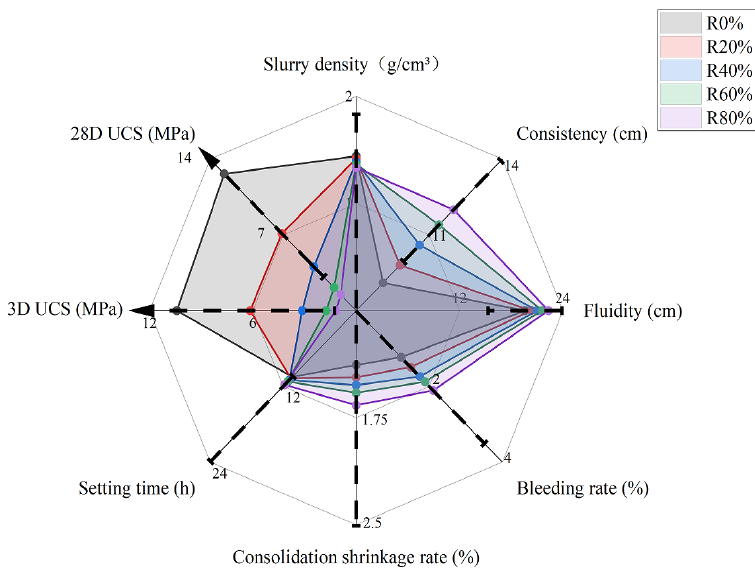
Figure 5. Performance with different rubber and porous sand content without fiber.